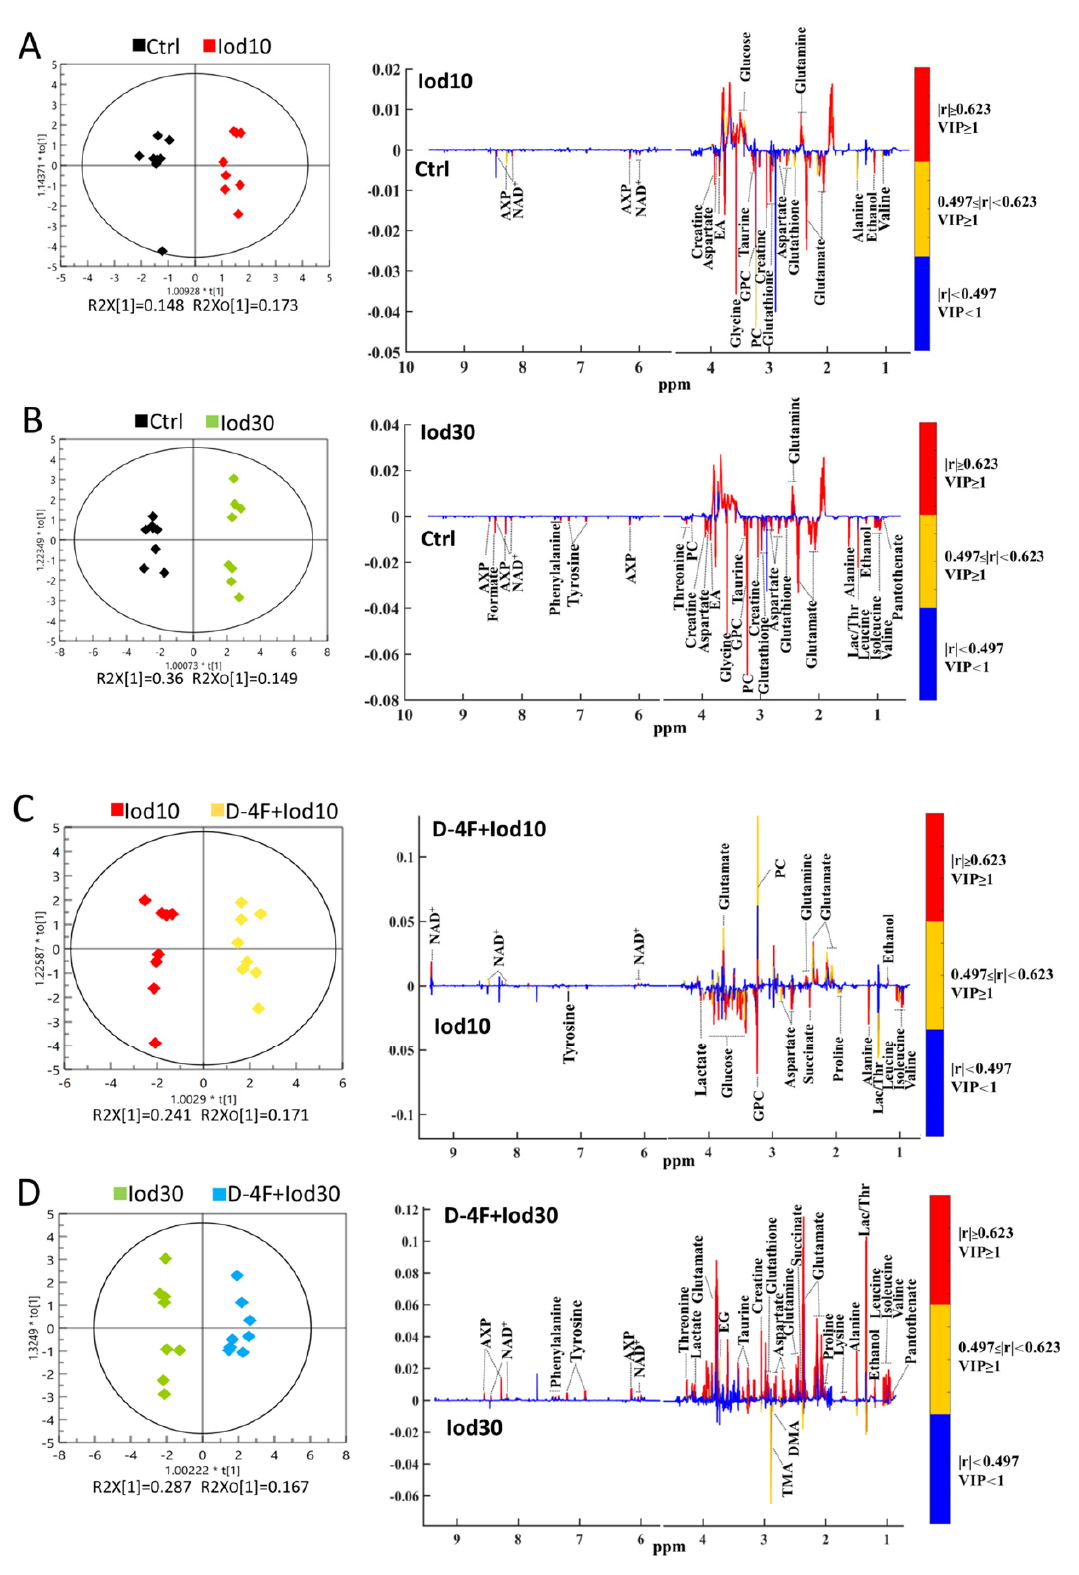
Figure 4. OPLS-DA score plots and corresponding correlation coefficient-coded loading plots for 1 H-NMR spectra recorded on aqueous extracts of HUVECs. The color pattern of the loading plot is used to identify the significant variables in the class separation. Red, orange and blue denote that the variables are very significant, significant and insignificant, respectively. ( A ) Iod10 vs. Ctrl; ( B ) Iod30 vs. Ctrl; ( C ) D ‐ 4F + Iod10 vs. Iod10; and ( D ) D ‐ 4F + Iod30 vs. Iod30 were shown.